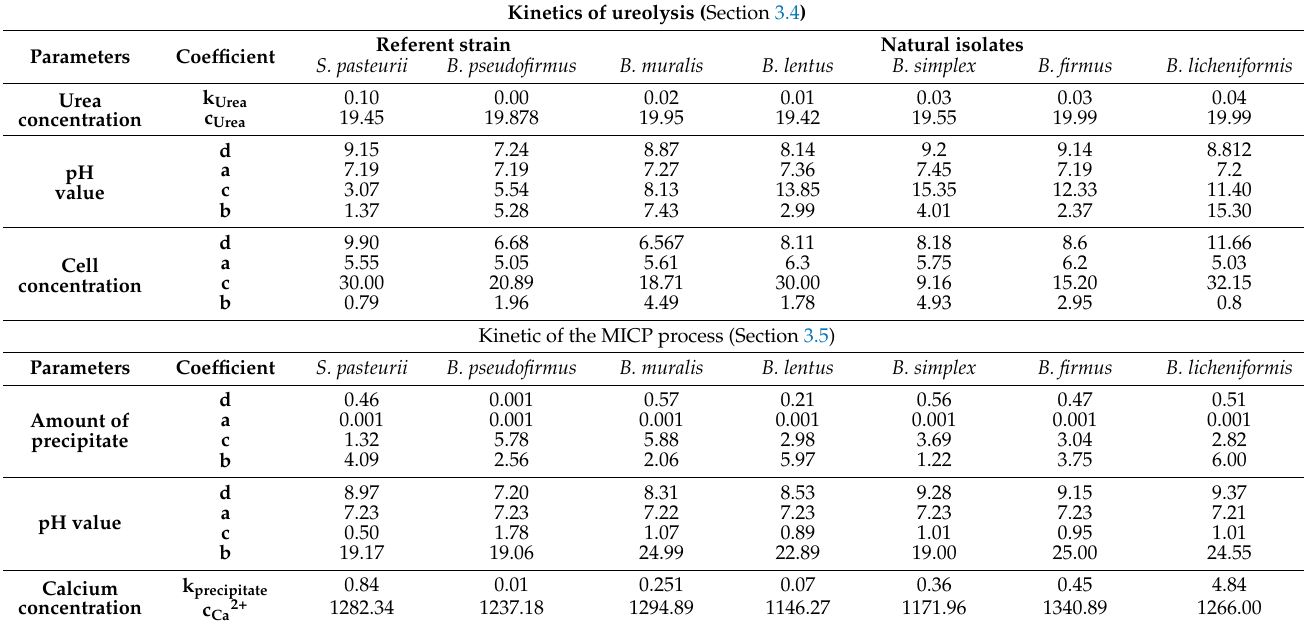
Table 1. Regression coefficients. Kinetics of ureolysis ( Section 3.4